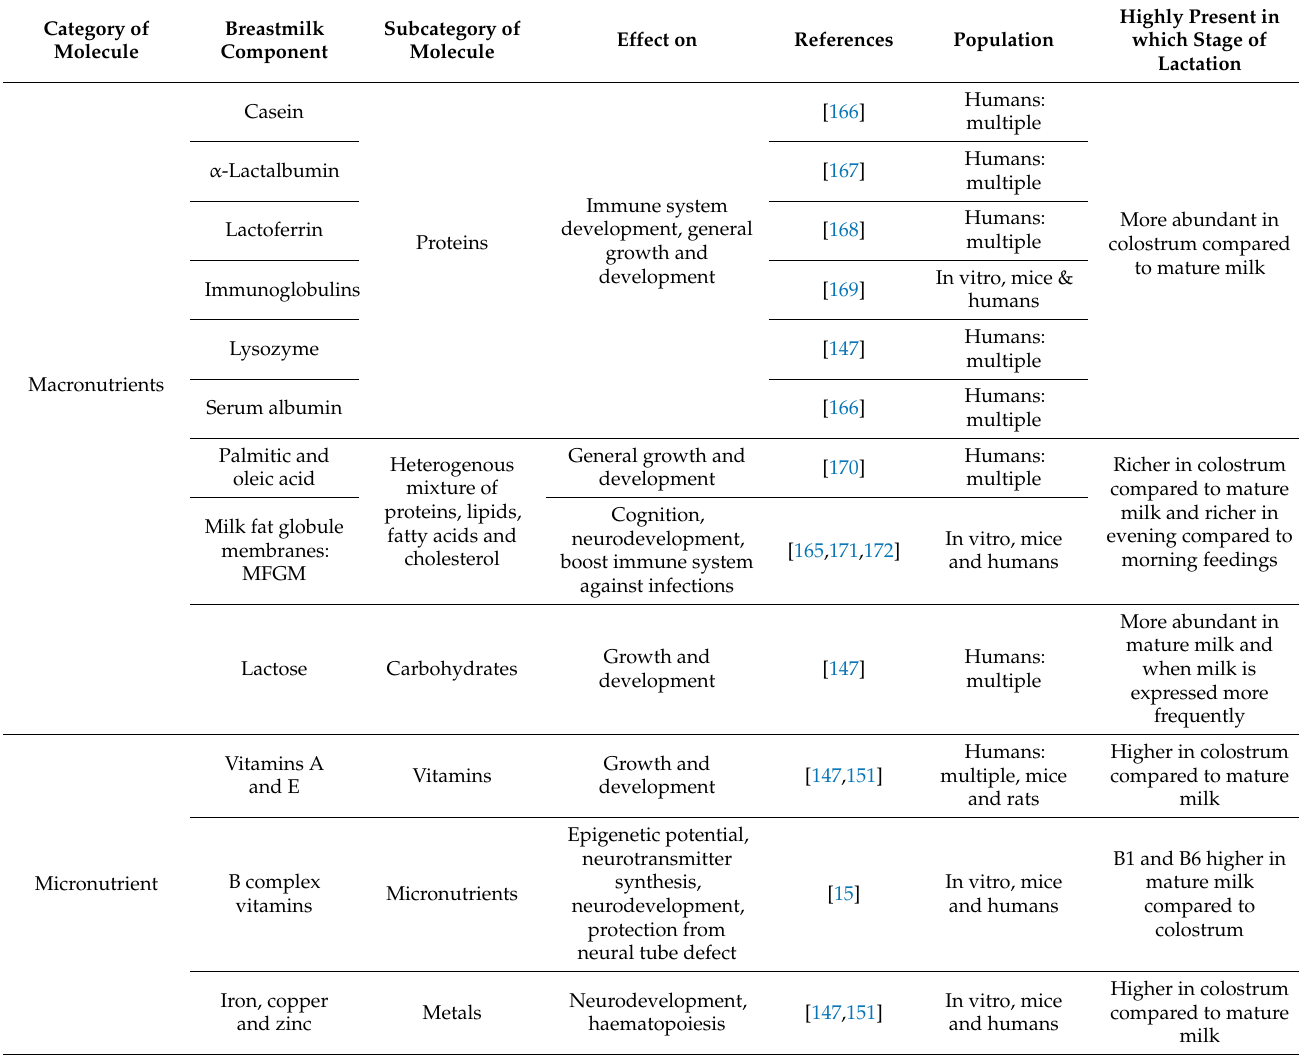
charides (HMOs) and breast milk microbiota are summarized in Table 3. Some bioactive components of breast milk, like the MFGM, may act as macronutrients too, providing the infant with energy or acting as building blocks for growth of various tissues. Table 2. Macro and micronutrients present in human milk, their effect on infant health and their expression in different stages of